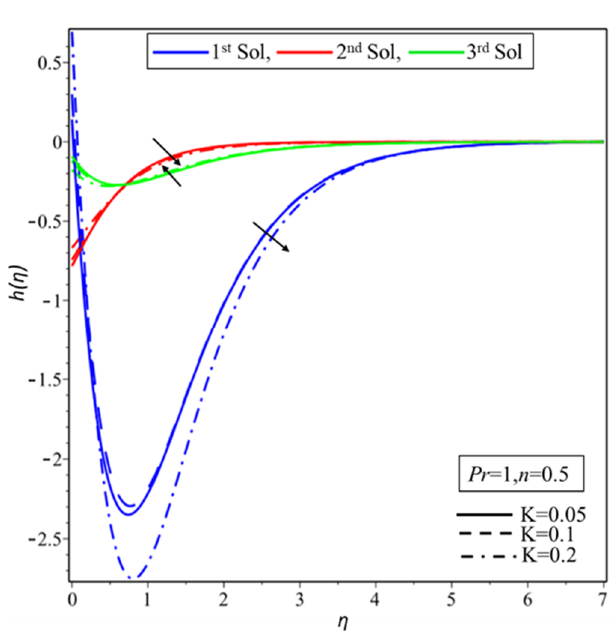
Figure 7. Effect of K on (cid:1858)′((cid:2015)) when S = 2.5 . Figure 7. E